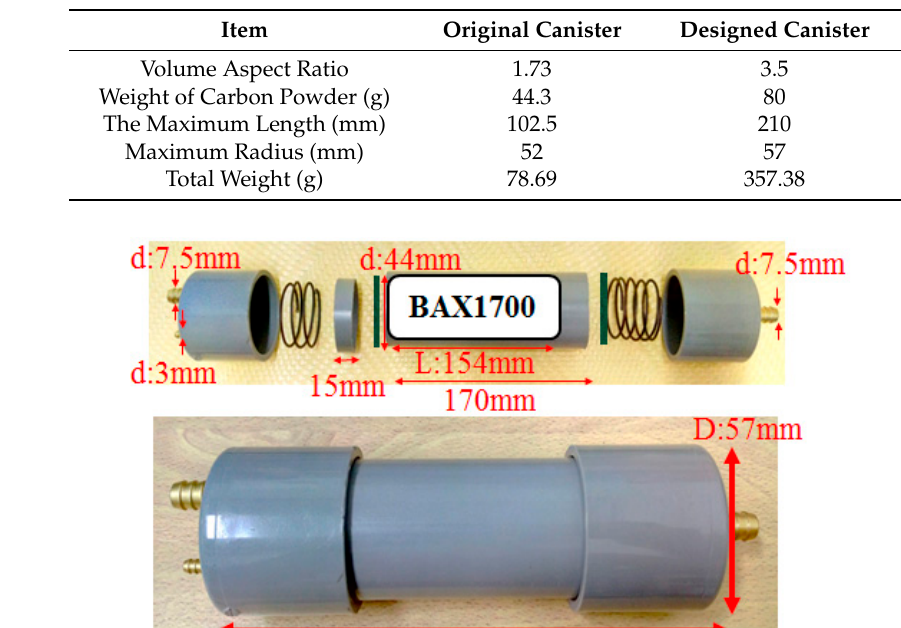
Table 2. Comparisons of carbon canister specifications.